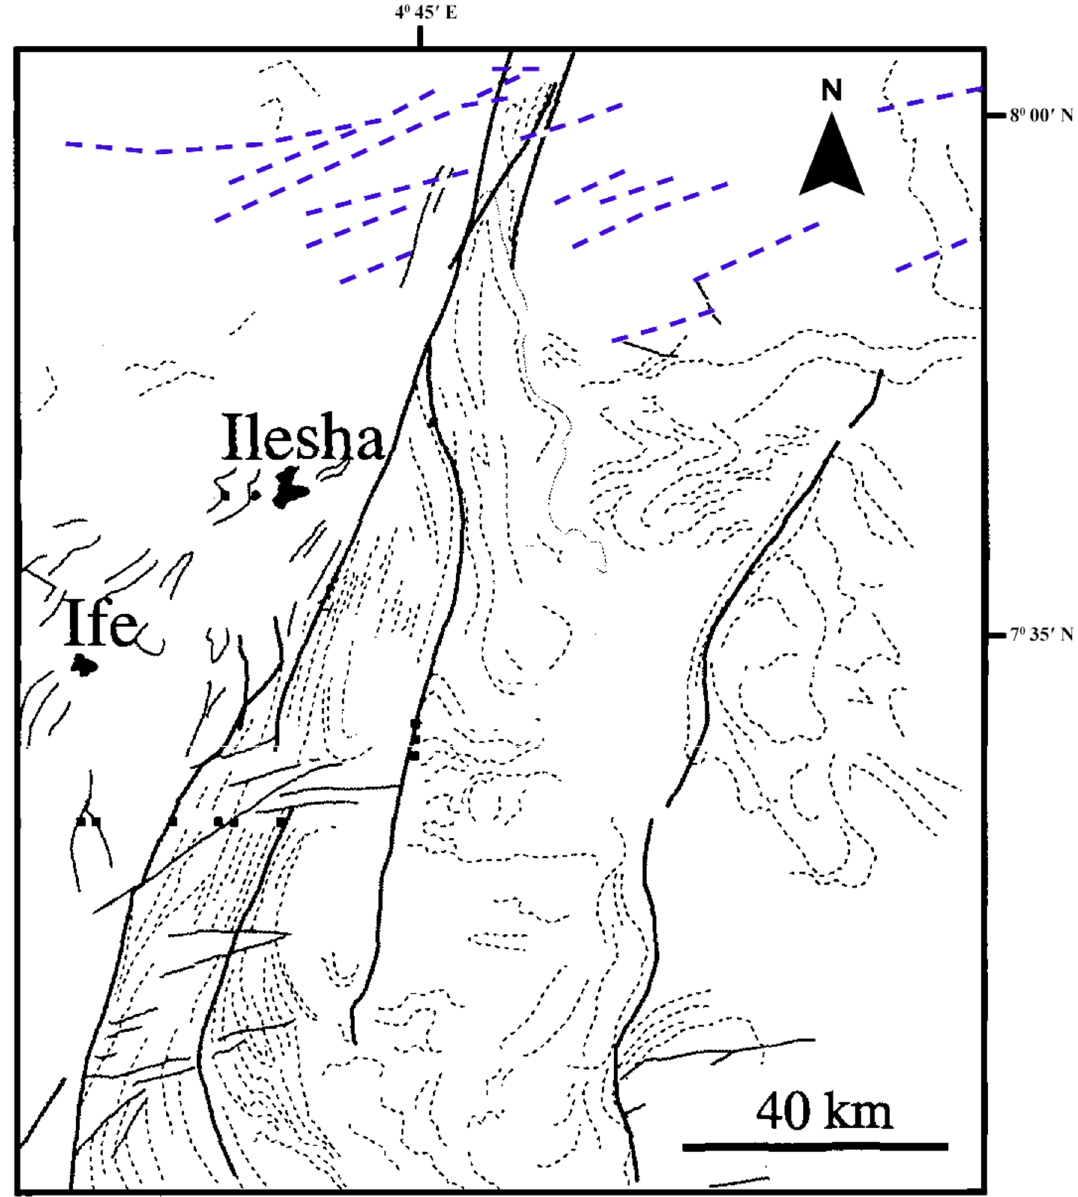
Figure 3. Structural map of the Ife-Ilesha schist belt established using Radar and Landsat images (modified from Ref. 10 ). Dashed blue lines: NE-trending structures which host Sn–Nb–Ta–productive pegmatites Refs. 1,21